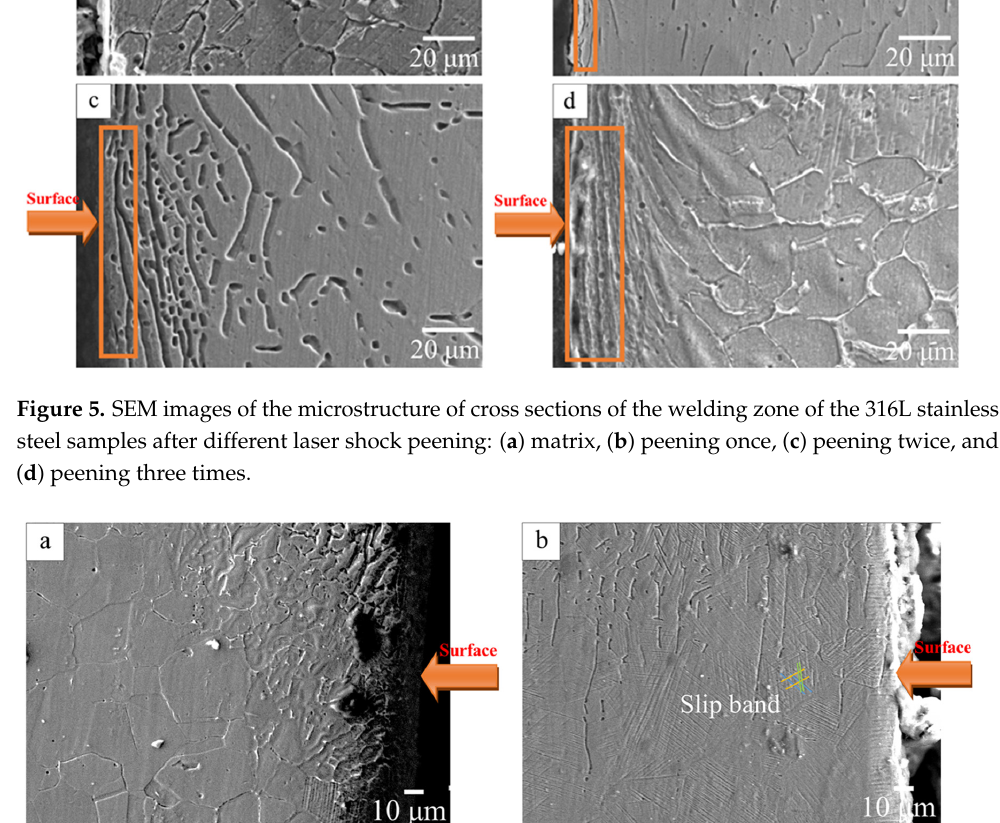
distance between dislocations, and b is the Parker